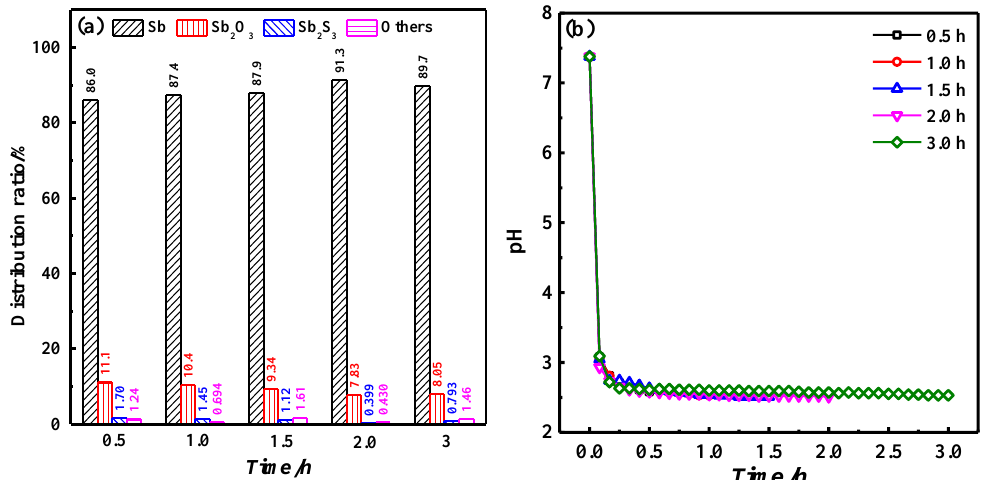
Figure 8. ( a ) Phase distribution ratio of Sb in the roasted products; and ( b ) pH value of KMnO 4 solution at different roasting times.